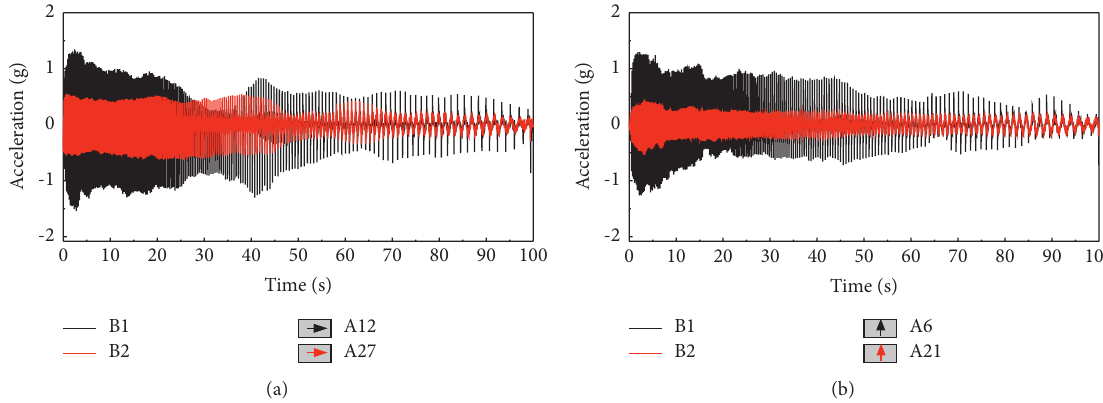
Figure 14: Acceleration time history: 0.15 g sweep. (a) Response in X direction and (b) response in Y direction.